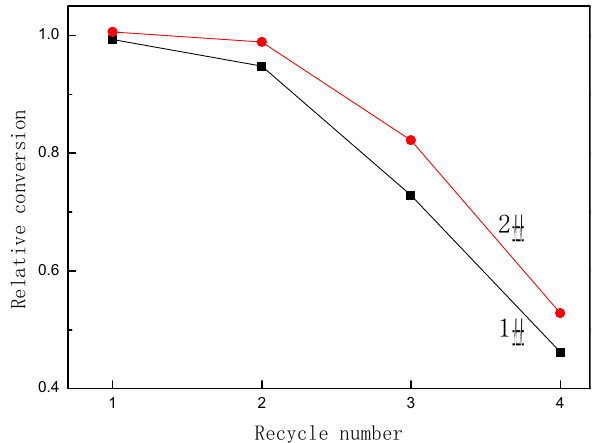
Figure 8: The activity of the